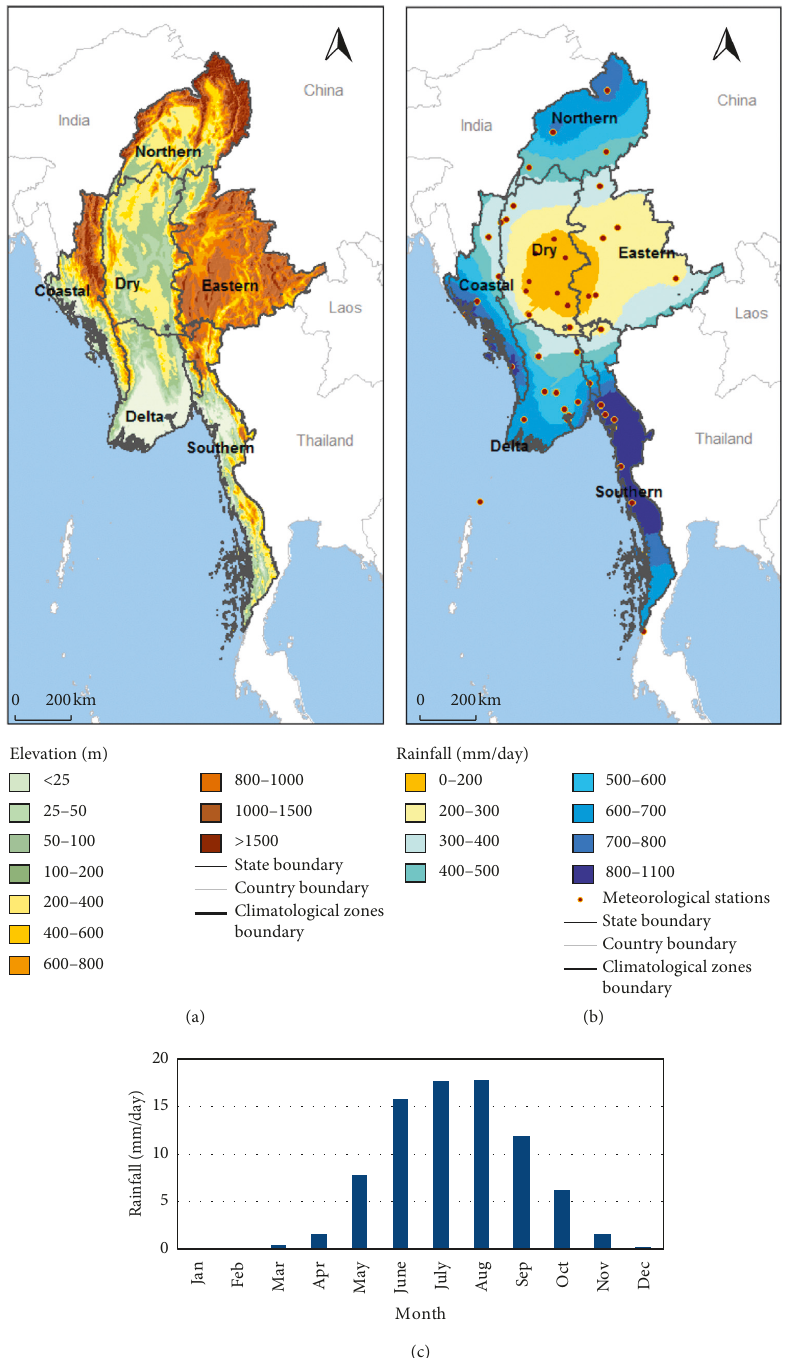
Figure 1: (a) Topography of Myanmar. (b) Rainfall during June to September overlaid with meteorological surface observatory and climatological zones. (c) Monthly climatology of